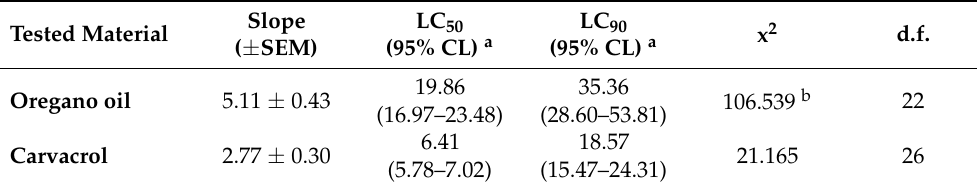
Table 1. LC 50 and LC 90 values for the oregano oil and its major component carvacrol against 3rd